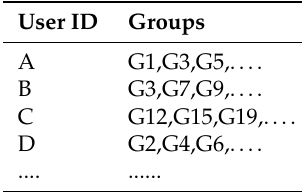
Table 8. Groups dataset in kvs format.